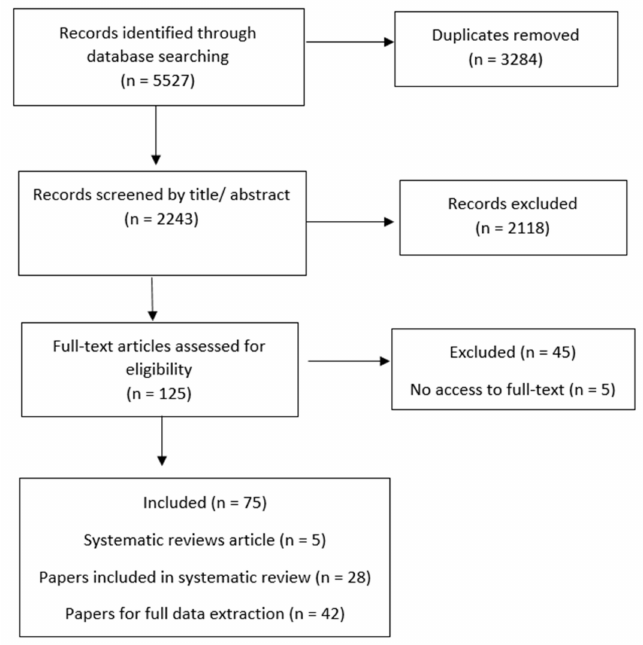
Figure 1. Search and extraction